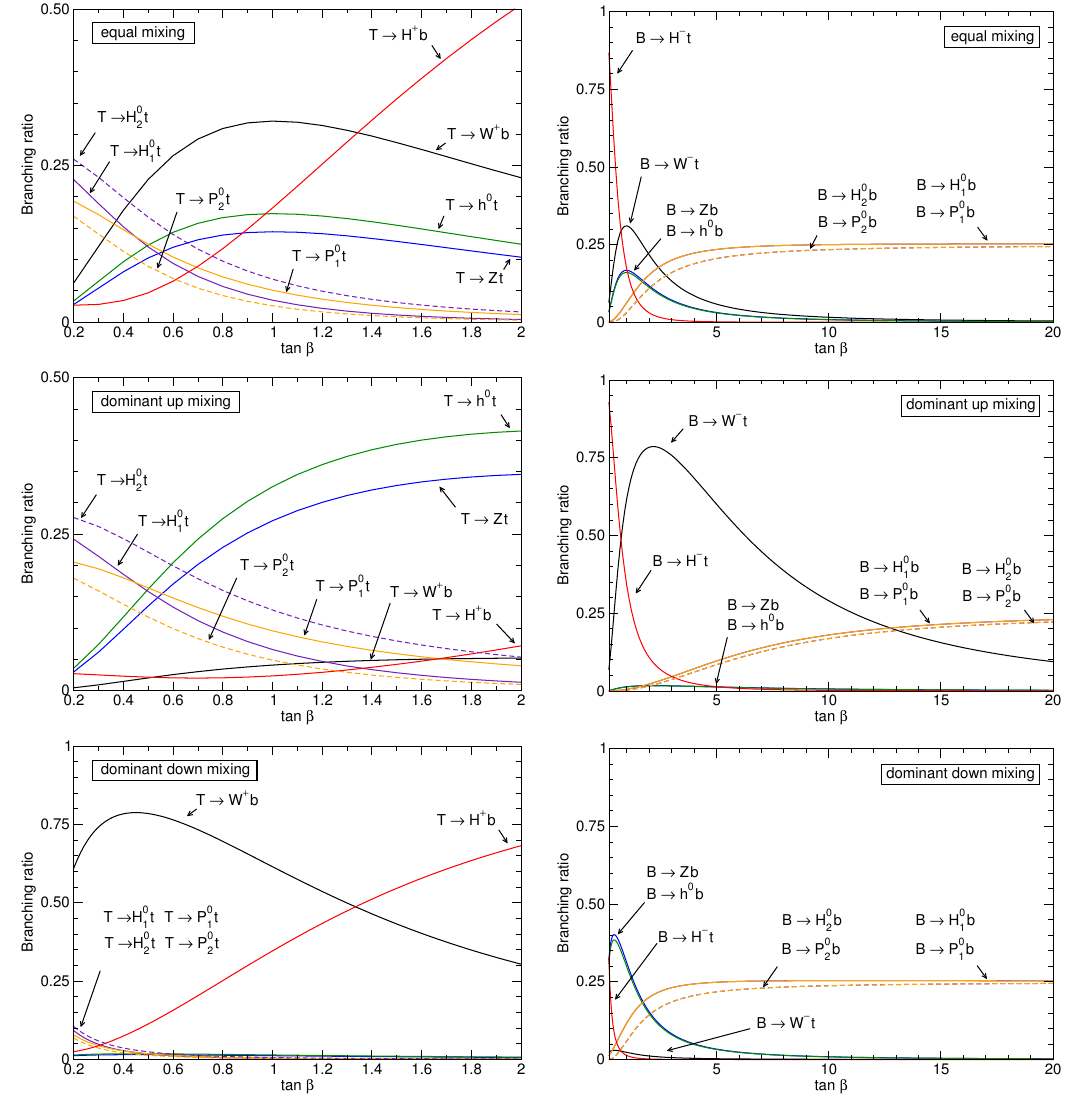
Figure 3 . Dependence of the T and B branching ratios on tan (cid:12) , for the equal mixing and dominant up/down mixing scenario of tables 1, 2 and